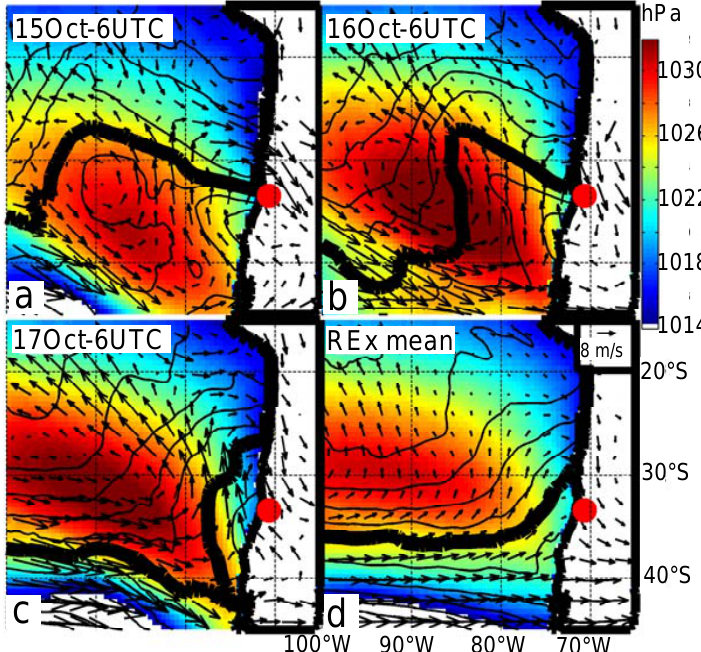
Fig. 15. WRF-Chem simulation surface pressure (colored contours), 500hPa heights (line contours) and 700hPa winds (arrows) at (a–c) in days preceding Hook1 at 06:00UTC, and (d) REx mean conditions. The red circle marks Santiago. The bold 500hPa contour is 5350m and the contour interval is